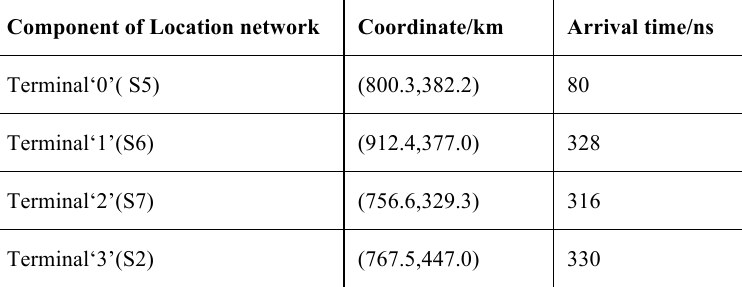
Table 1 Data at each terminal of Location network